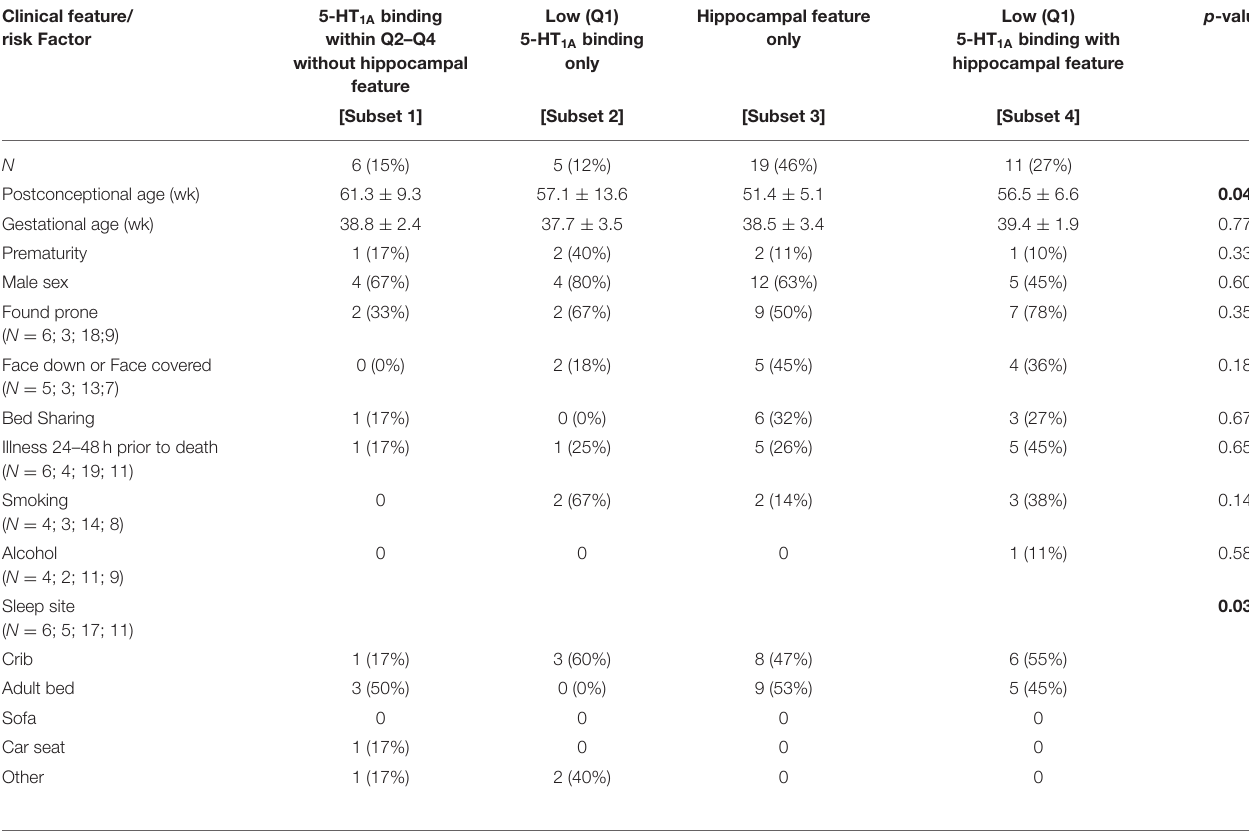
TABLE 8 | Clinical and risk factor profile by medullary 5-HT 1A binding and hippocampal feature (clusters of immature cells in the subgranular layer). Clinical feature/ risk